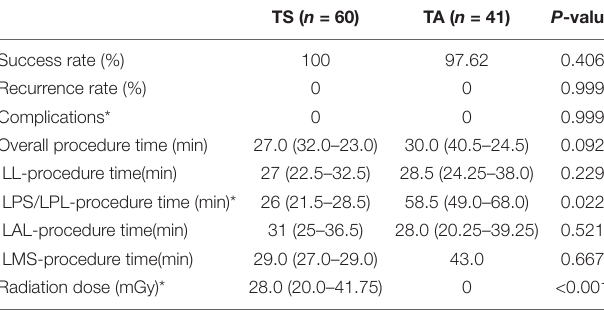
TABLE 2 | Ablation outcomes and follow-up results of patients in TS and TA